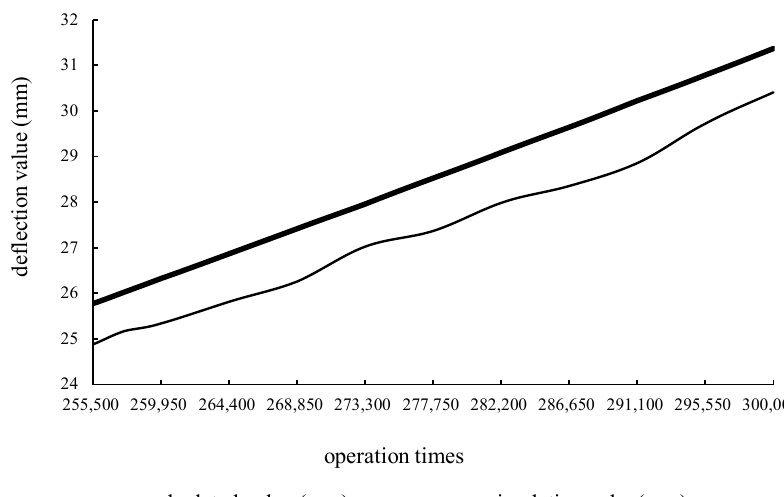
Figure 8. Data validation curve.